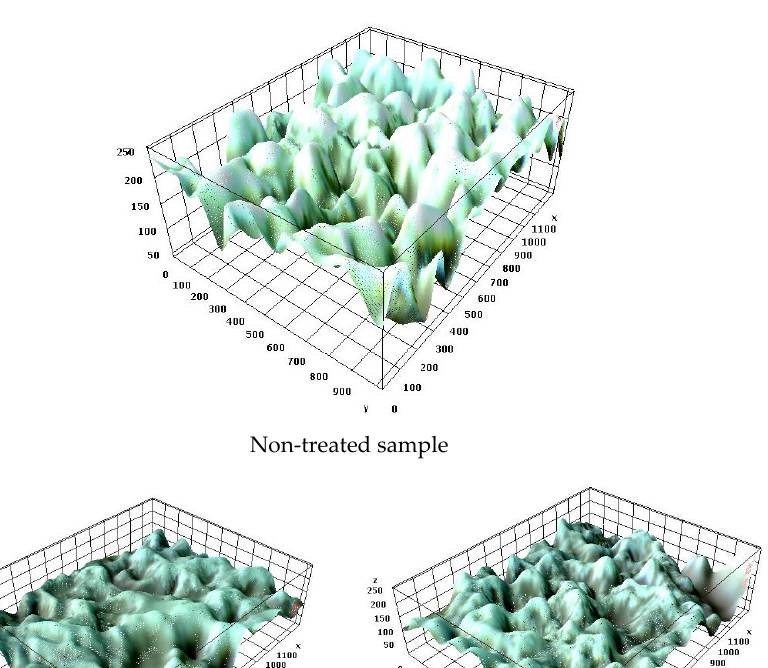
the peaks marked with the white area indicate higher roughness of the material. A higher roughness of the material is observed.